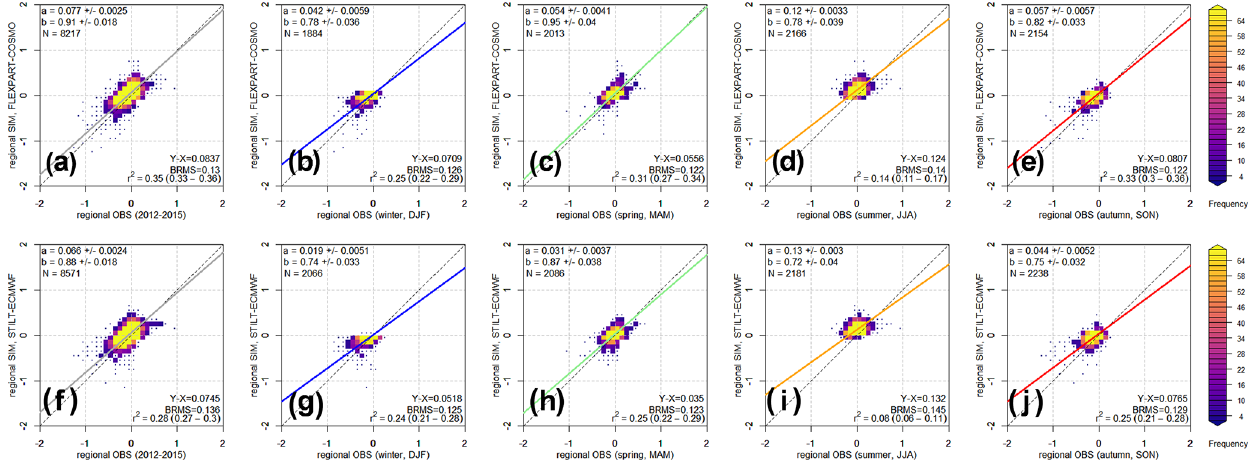
Figure 10. Heat maps of model-based regional δ 13 C–CO 2 (SIM) vs. observation (OBS) (3-hourly data) for FLEXPART–COSMO (a–e) and STILT-ECMWF (f–j) during 2012–2015, for the full year (grey), and per season (DJF – blue, MAM – green, JJA – orange, SON – red). Uncertainties in the x and y axes are taken into account in the weighted least squares regression applied here (a full-page version of this figure is available in the